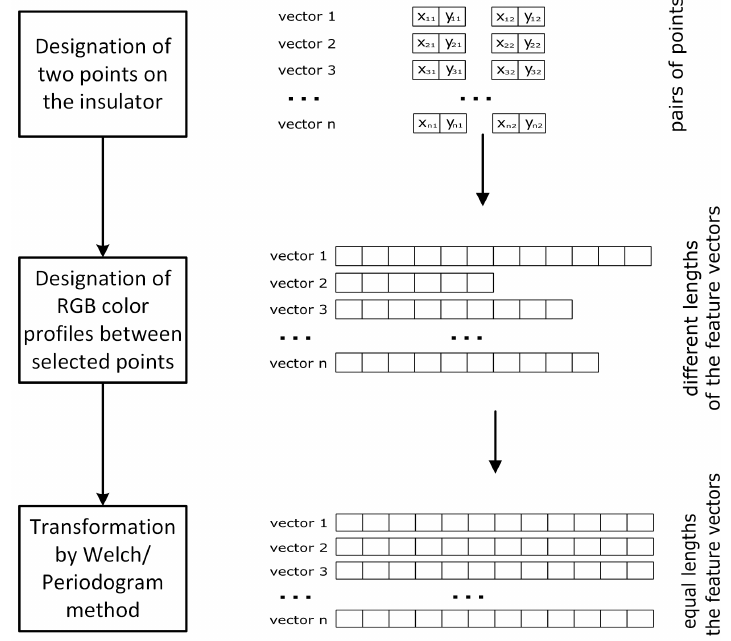
Figure 2. Transformation of the colour intensity profiles determined between individual points (vectors with different lengths depending on the distance between pairs of points) into feature vectors of equal length.